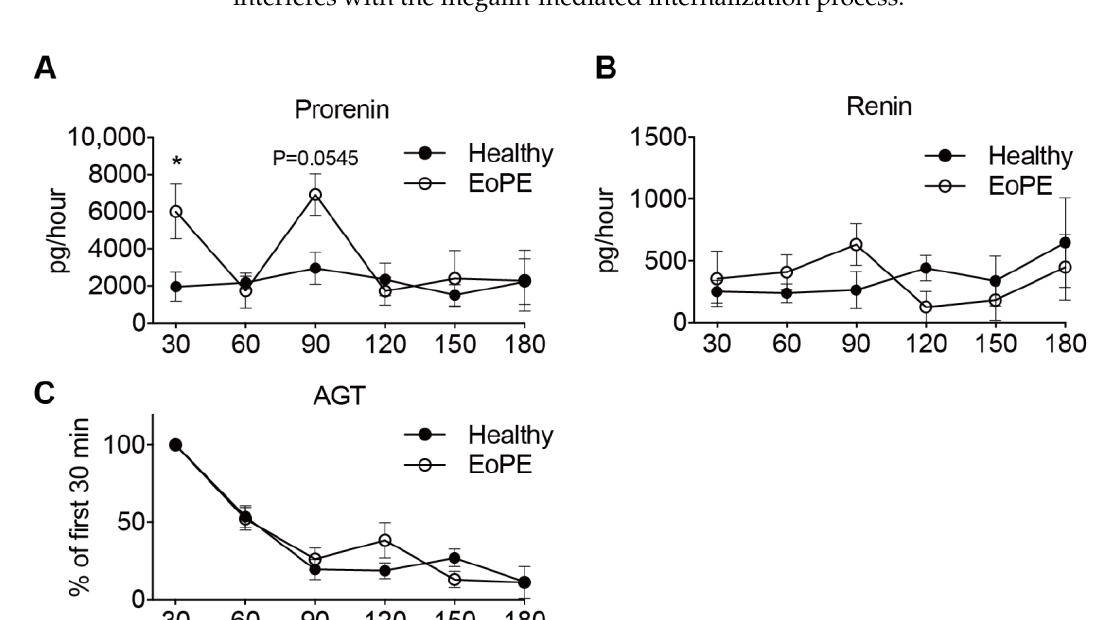
Figure 3. Prorenin ( A ), renin ( B ) and angiotensinogen ( C ) release from isolated perfused healthy ( n = 5) and early-onset pre-eclamptic (EoPE, n = 6) cotyledons. AGT: angiotensinogen. Perfusate collection from two of the pre-eclamptic placentas could not be continued over the full 180 min due to fetal-to-maternal leakage. In such cases, only the samples prior to the occurrence of leakage were used. Data are mean ± SEM. * p < 0.05.